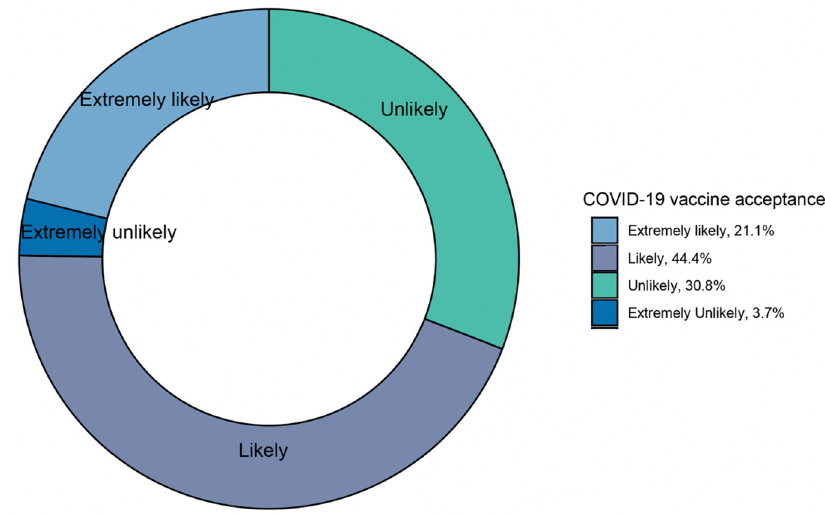
Figure 1. COVID-19 vaccine acceptance of the participants in Japan ( N = 1037).